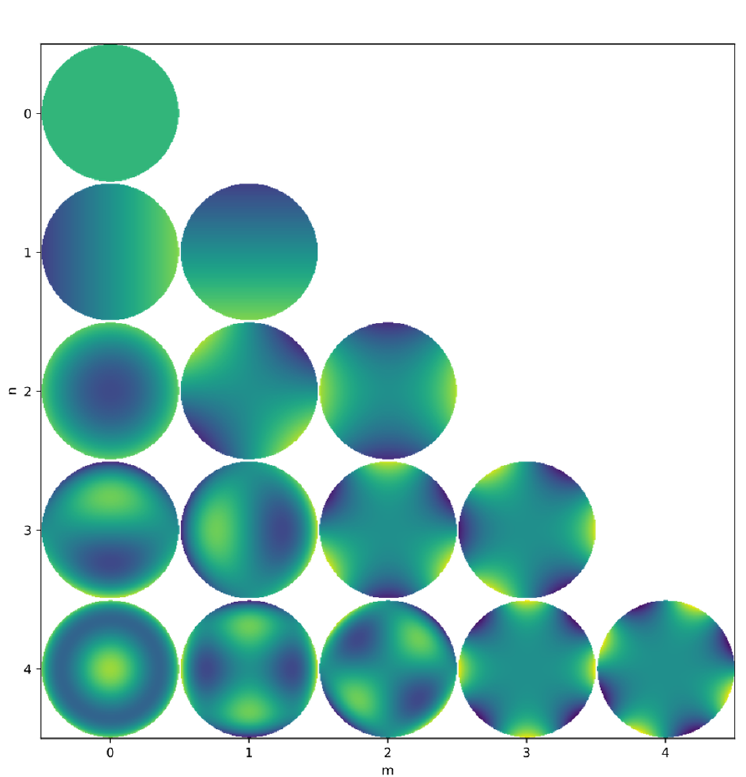
Figure 2. Zernike modes from 𝑍 (cid:2868)(cid:2868) to 𝑍 (cid:2872)(cid:2872) . The rotational symmetry is only shown in modes where n is even, and m is 0.